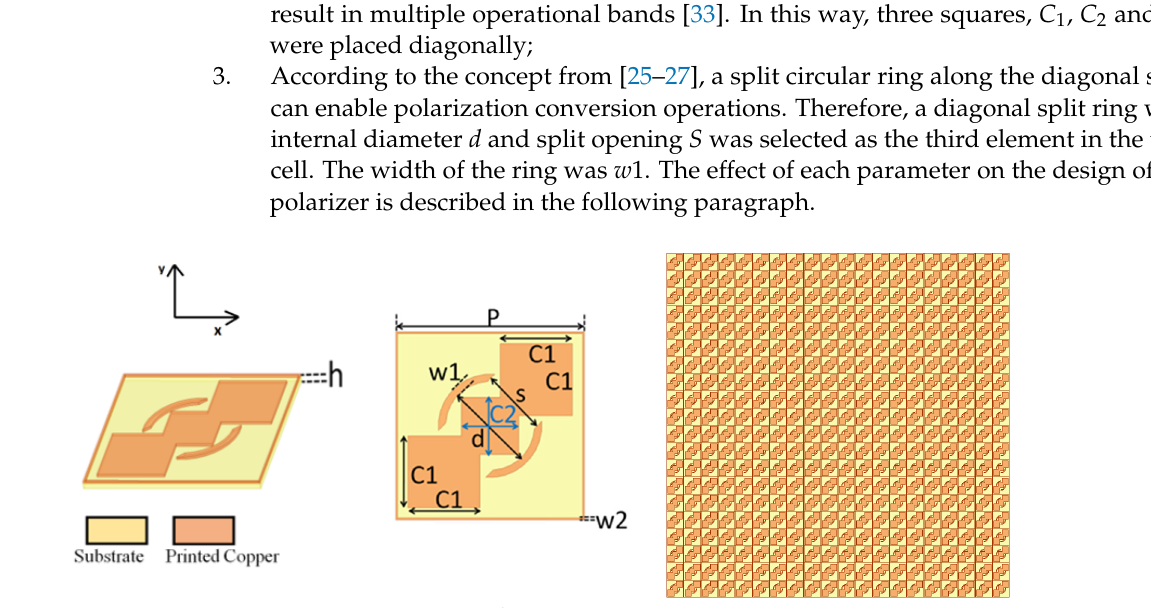
Table 1. Design parameters for the proposed polarizer .